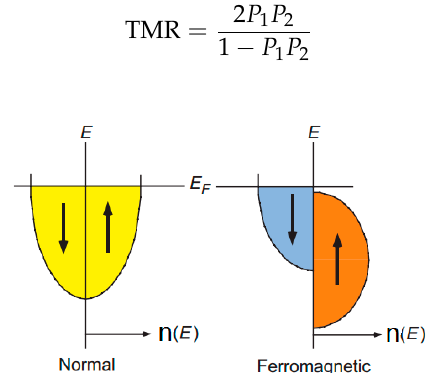
Figure 1. A schematic of the density of electronic states in normal and ferromagnetic metals. The density is equal for the normal metal, and imbalanced for the ferromagnetic. E is the electron energy; E F is the Fermi energy level; n (E) is density of states. Adapted from [3], with permission from © 1998 The American Association for the Advancement of Science.